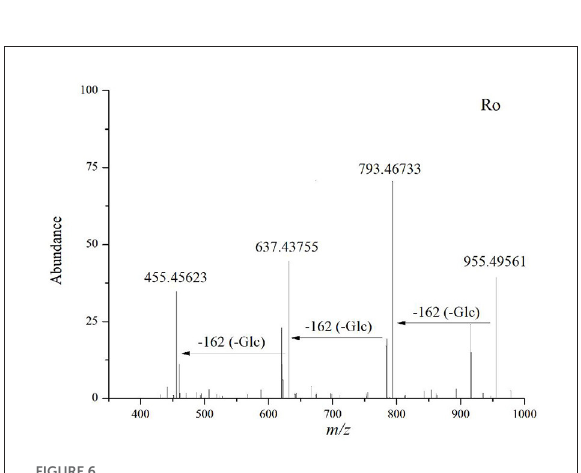
Figure 9C. Validation of the OPLS-DA model was conducted by